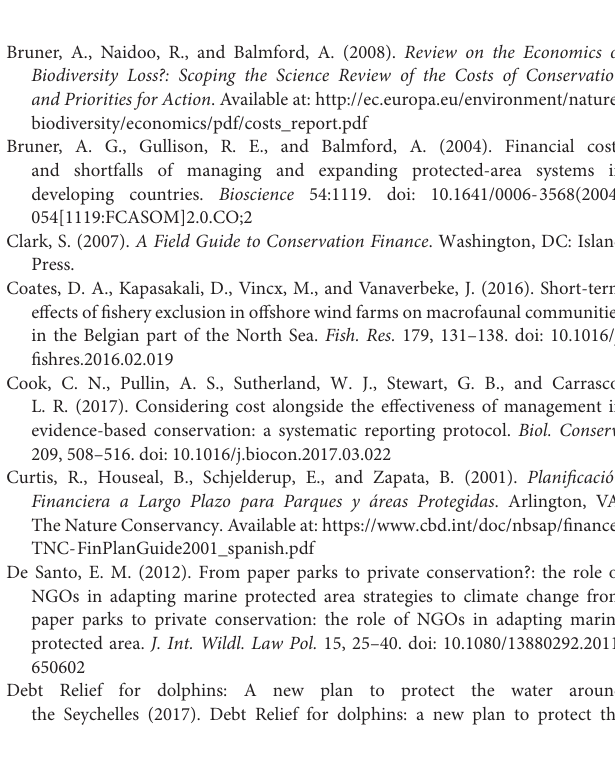
TABLE S1 | Costs and calculated ratios for individual conservation scenarios within each study assessed in the quantitative